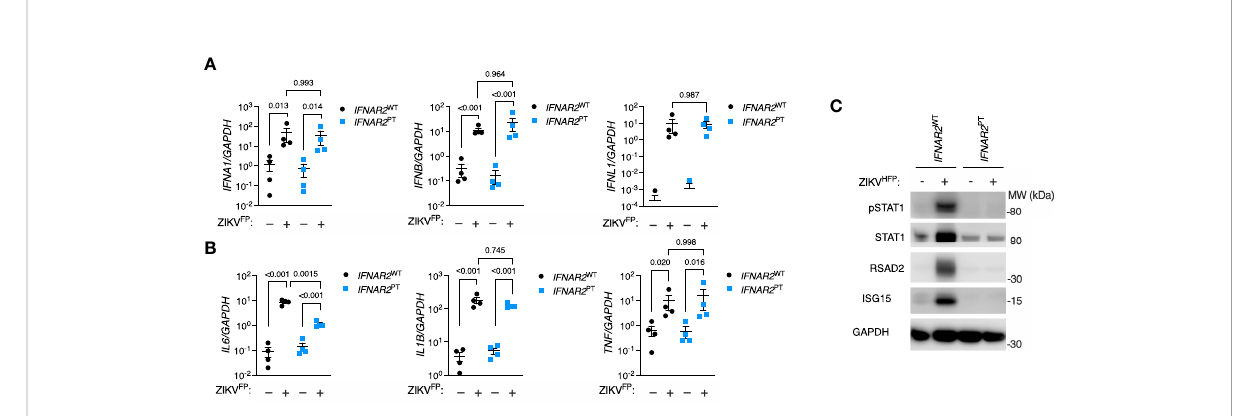
FIGURE 2 IPS-macrophages mount a robust IFN-I response to ZIKV infection. (A) RT-PCR quanti fi cation of IFNA1 , IFNB and IFNL1 relative to GAPDH (24 h .p.i. ZIKV FP MOI = 10.0, n = 4 independent experiments in IFNAR2 WT [WT2] and IFNAR2 PT [clone 6]). Mean ± SD, ANOVA with Sidak ’ s test for multiple comparisons. (B) RT-PCR quanti fi cation of IL6 , TNF and IL1B relative to GAPDH (24 h .p.i. ZIKV FP MOI=10.0, n = 4 independent experiments in IFNAR2 WT [WT2] and IFNAR2 PT [clone 6]). Mean ± SD, ANOVA with Sidak ’ s test for multiple comparisons. (C) Immunoblot of pSTAT1, STAT1, RSAD2, GAPDH and ISG15 in IFNAR2 WT (WT2) and IFNAR2 PT (clone 11) iPS-M f (48 h.p.i. ZIKV FP MOI=1.0), representative of n = 3 independent experiments including IFNAR2 PT (clone 6) and IFNAR2 WT (WT1) iPS-M f